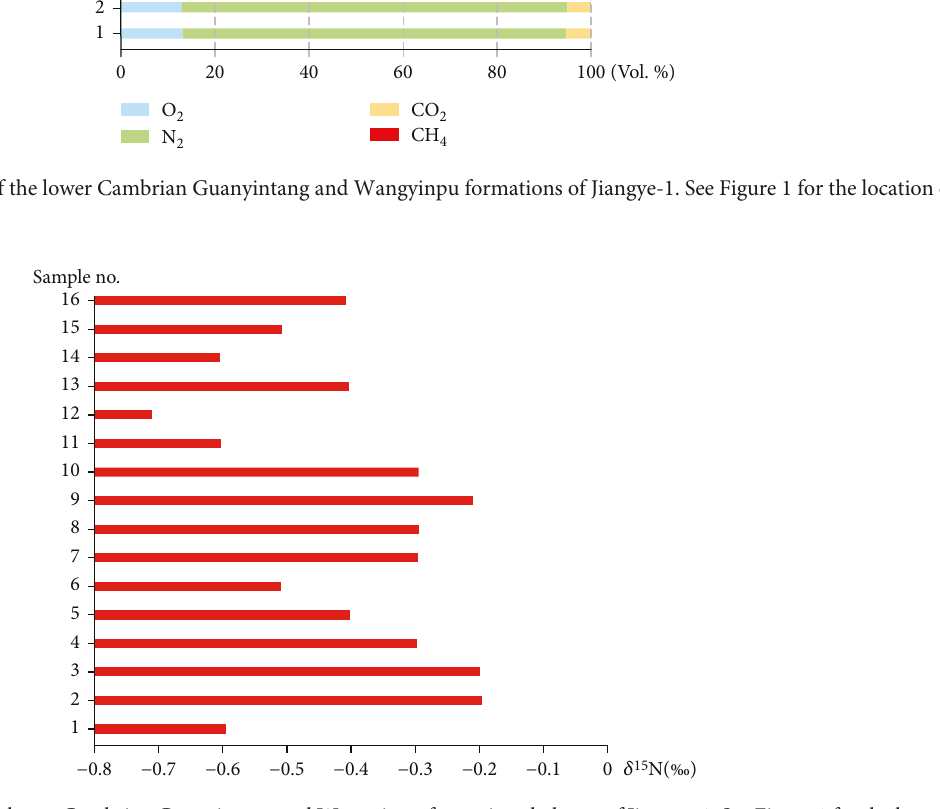
Figure 5: δ 15 N content of the lower Cambrian Guanyintang and Wangyinpu formation shale gas of Jiangye-1. See Figure 1 for the location of the well location. Table 3: Summarized characteristics of stable nitrogen isotope of nitrogen in natural gas of di ff erent sources (modi fi ed from Zeng [42] and Liu et al.